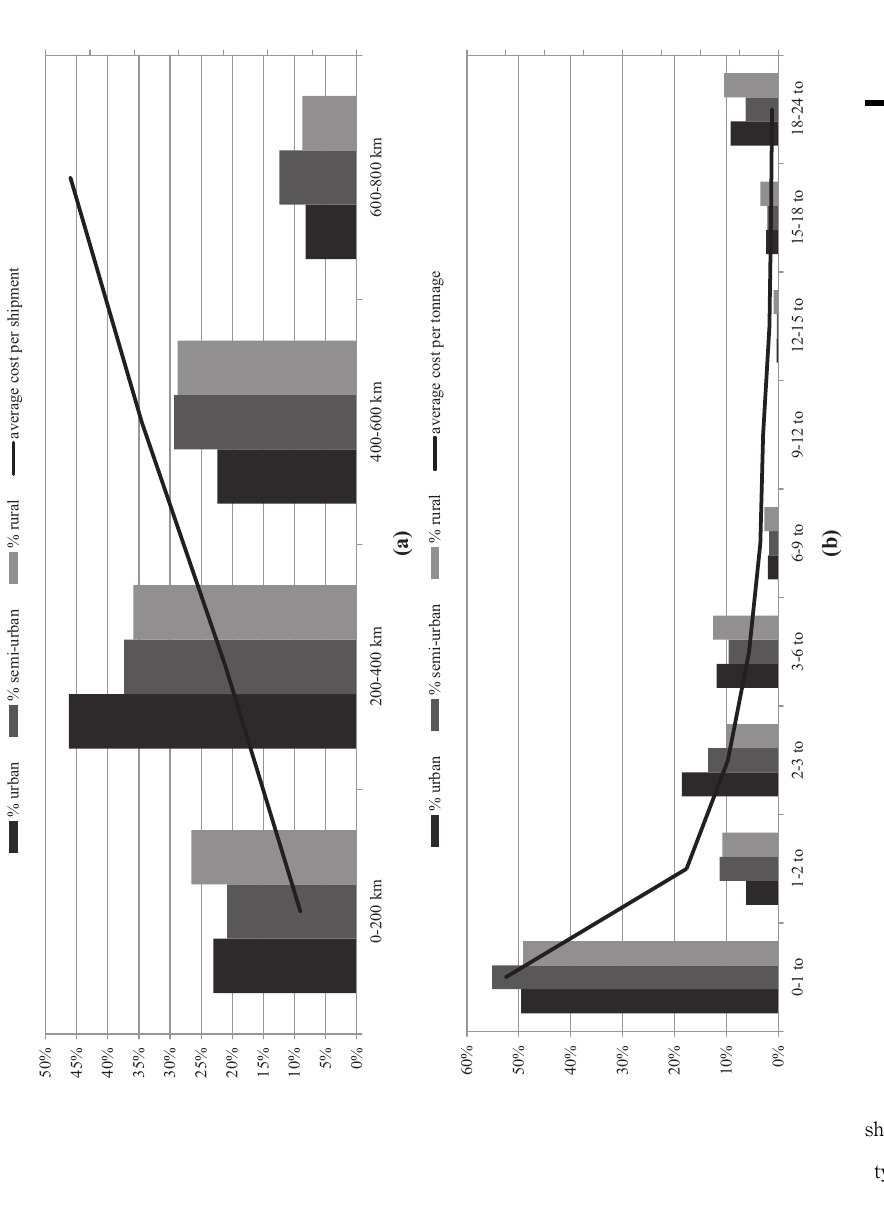
Figure 4. Shares of total shipments according to (a) distance and area type and (b) shipment size and area